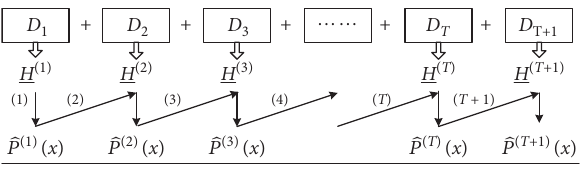
Figure 1: When the newly coming data D T + 1 arrive at the learning system, I-KDE uses equation (14) to update the current p.d.f. rather than reestimate the p.d.f. for the combination of current data and newly coming